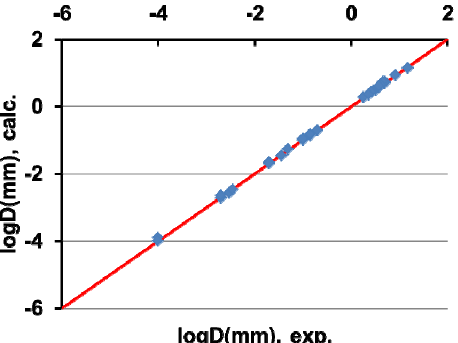
Figure 3. Calculated liquid droplet diameters versus experimental liquid droplet